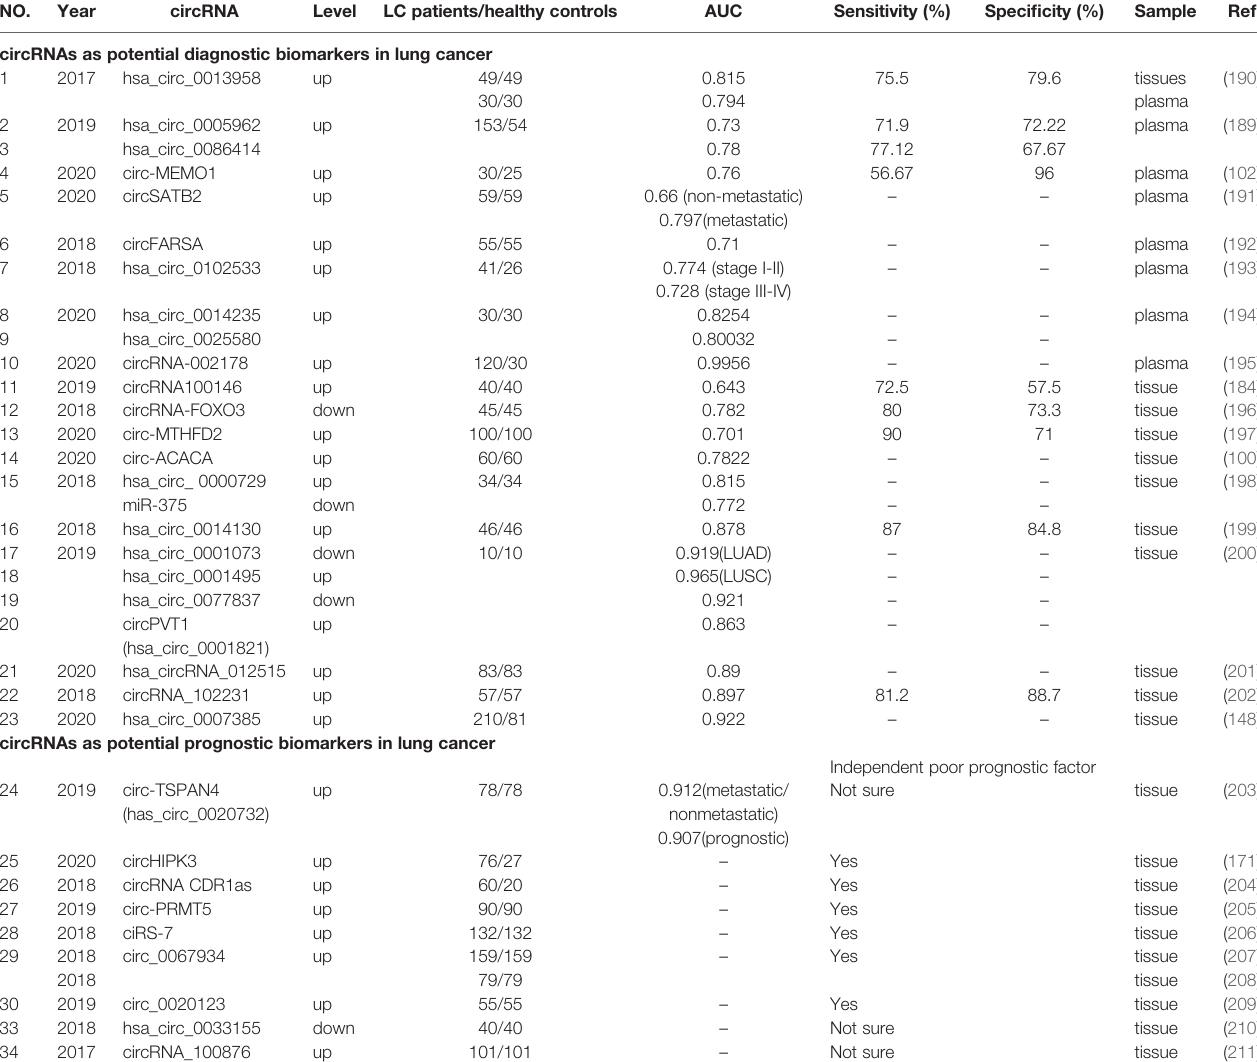
TABLE 3 | circRNAs as potential biomarker for diagnosis and prognosis in lung cancer.